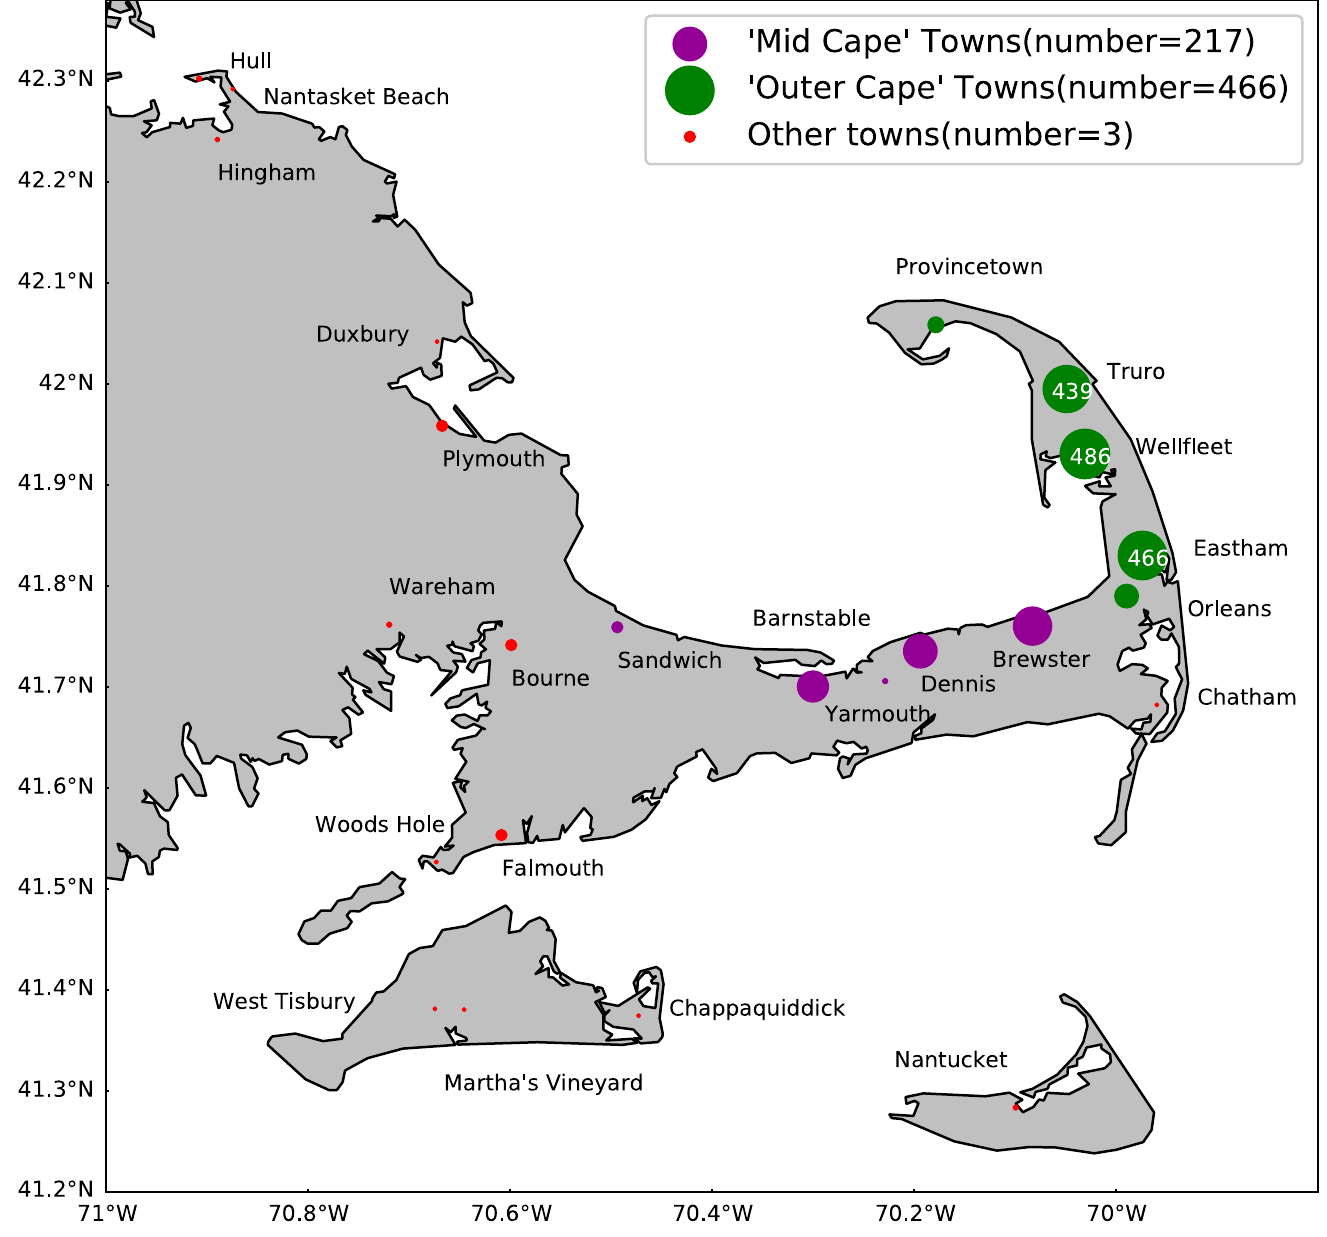
Fig 4. Total turtle strandings per town from 2012–2015. Most of the Outer Cape towns (green dots) had > 400 strandings while some of the Mid Cape towns (purple) had ~200. All strandings from these sections were found on the Cape Cod Bay side of the towns.